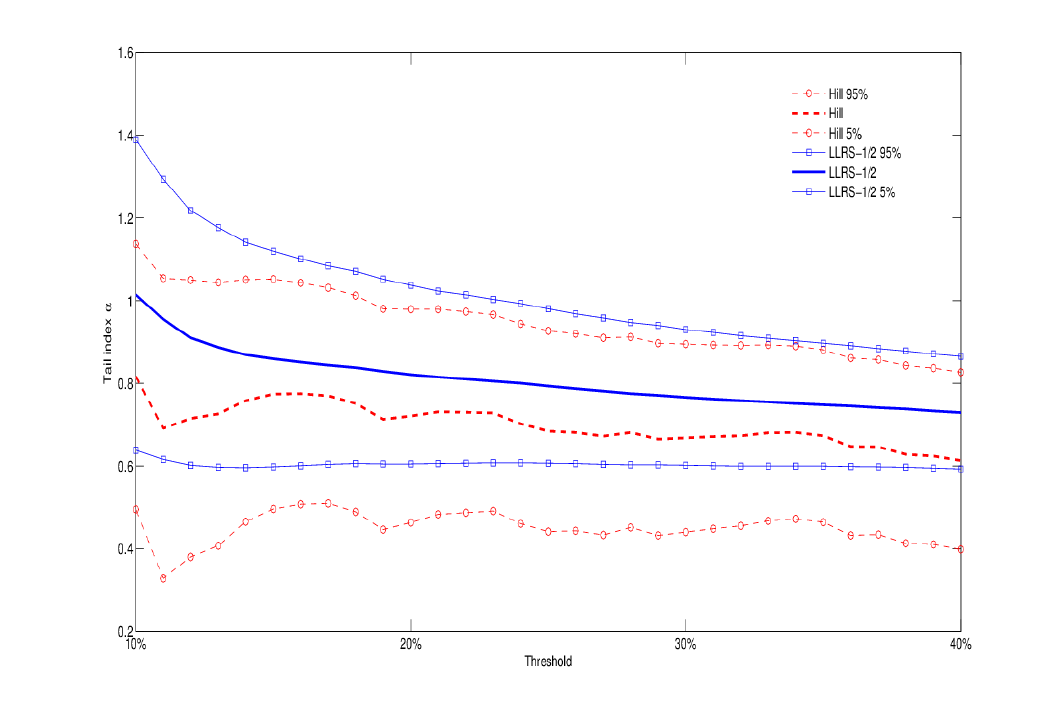
Figure 2. Tail index estimates and 90% confidence bands for Occupancy Level 1 RE (residential): comparison of Hill and LLRS-1/2 regression methods for different estimation thresholds (from 10-th to 40-th percentile of the